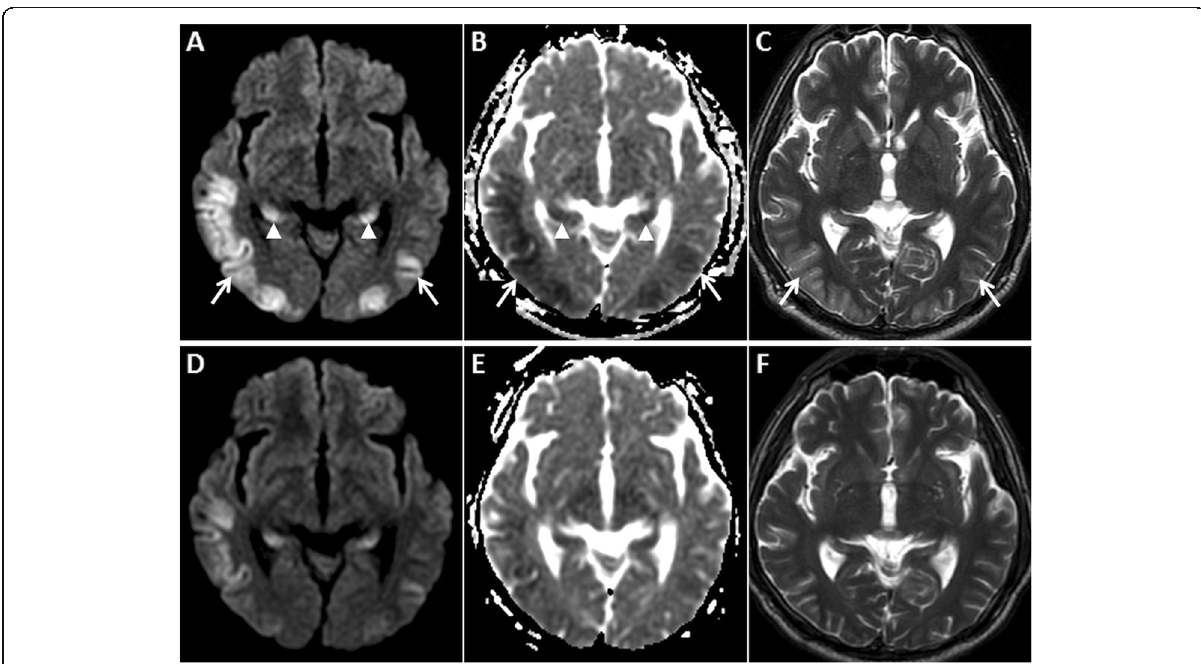
Fig. 5 MRI of the brain in a 46-year-old male patient diagnosed with hypoglycaemia on the background of diabetic ketoacidosis. Bilateral asymmetric GRD, more on the right, is seen in the temporo-occipital lobes (arrows) on axial DWI ( a ) and ADC image ( b ). Restricted diffusion is also seen in bilateral hippocampi (arrowheads). Mild hyperintensity is noted in the involved cortex (arrows) on the axial T2W image ( c ). Post- treatment follow-up MRI after 2 weeks shows partial resolution of signal changes on axial DWI and ADC images ( d , e , respectively). Note that the axial T2W image also appears almost unremarkable ( f